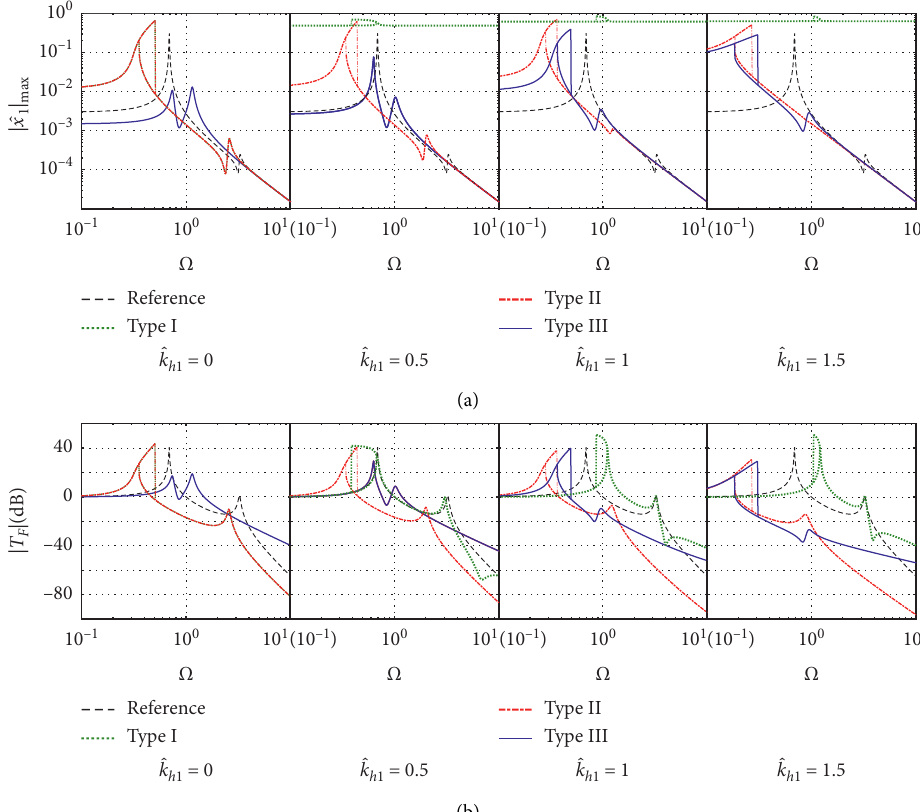
Figure 2: Top plots: displacement amplitude-frequency responses for the payloads in four types of two-stage isolators, for μ � 0 . 2, ζ � ζ � 0 . 01, 1 2 􏽢 k � 􏽢 k � 1 . 0, 􏽢 l � 0 . 7, and F � 0 . 0015. Bottom plots: magnitudes of the force transmissibility in four types of two-stage isolators. Black dashed h 2 v 2 � 􏽢 k � 0; red dashed-dotted lines, type I; green dotted lines, linear two-stage isolator (corresponding to a model as shown in Figure 1(a) with 􏽢 k h h 2 1 lines, type II; blue solid lines, type III. The responses and the force transmissibility of three nonlinear isolators are compared for different values of 􏽢 k � 0, 􏽢 k � 0 . 5, 􏽢 k � 1 . 0, and 􏽢 k � 1 . 15 (if 􏽢 k � 1 . 0 and 􏽢 l � 0 . 7, the the upper lateral stiffness 􏽢 k h : 􏽢 k h h 1 h 1 h 1 h 1 reaches a value beyond 1.15 when v 2 1 1 nonlinear isolator systems can easily become bi-stable for small changes of stiffness, which is undesirable and is not considered in this